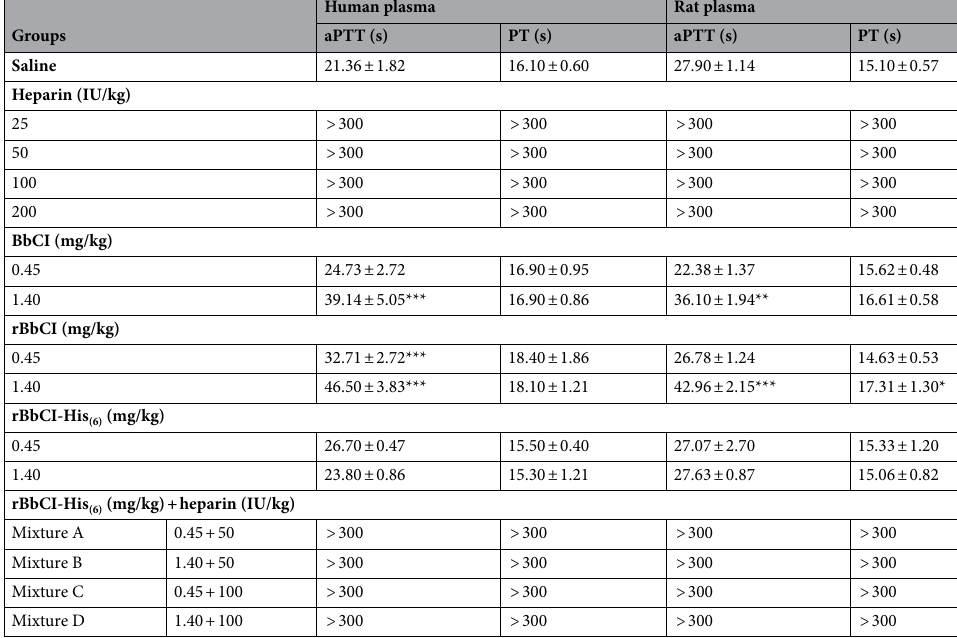
Table 2. Determination of the anticoagulant action of heparin and BbCI (aPTT and PT) in human and rat plasma. aPTT or PT parameters were determined using a plasma pool of 10 rats and a plasma pool of healthy human volunteers (n = 10). The plasmas were tested with saline or heparin or inhibitors or mixtures. Data are expressed as mean ± s.d. * p ˂ 0.05, ** p ˂ 0.01, *** p ˂ 0.001 versus corresponding values of plasma tested with saline. The normal range of the values of the PT (14.6 ± 1.7 s) and aPTT (26.6 ± 3.6 s) of the rats used in our laboratory was determined using Dade reagents. aPTT (activated partial thromboplastin time), PT (prothrombin time), Heparin (unfractionated